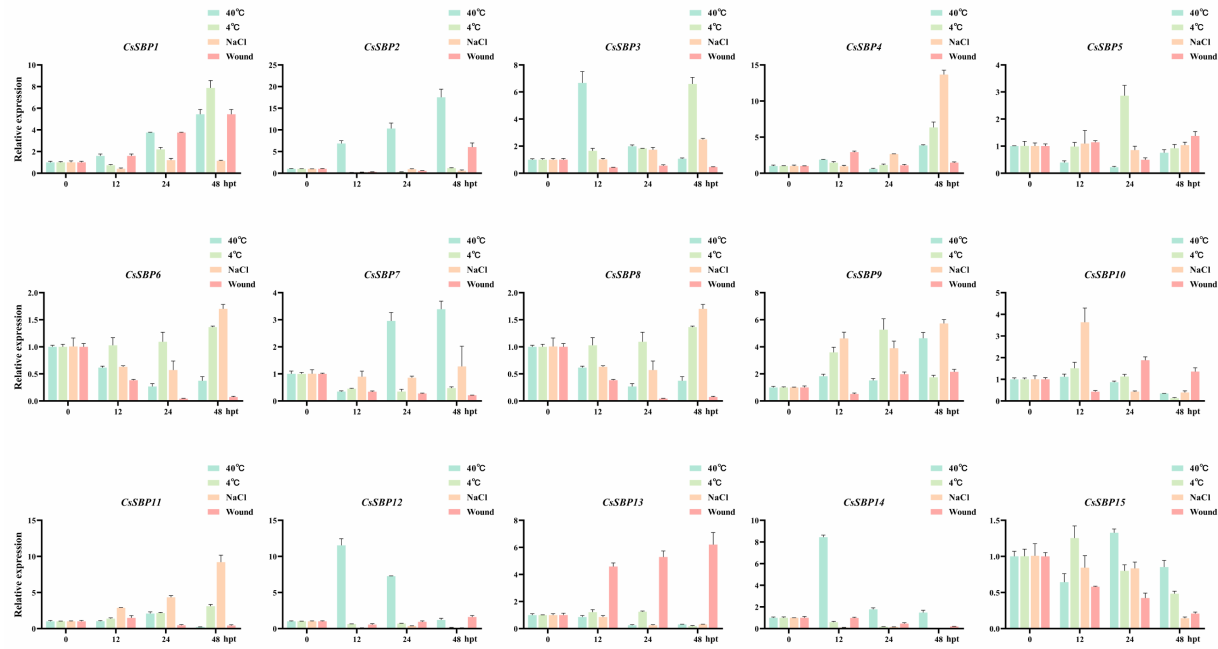
Figure 8. Expression levels of CsSBP genes under abiotic stress treatment. The Y-axis indicates the relative expression level; X-axis (0, 12, 24, and 48 hpt) indicates hours post abiotic stress treatment. Different colors represent different stress treatments. The standard errors are plotted using vertical lines. The experiments in all panels were repeated three times with similar